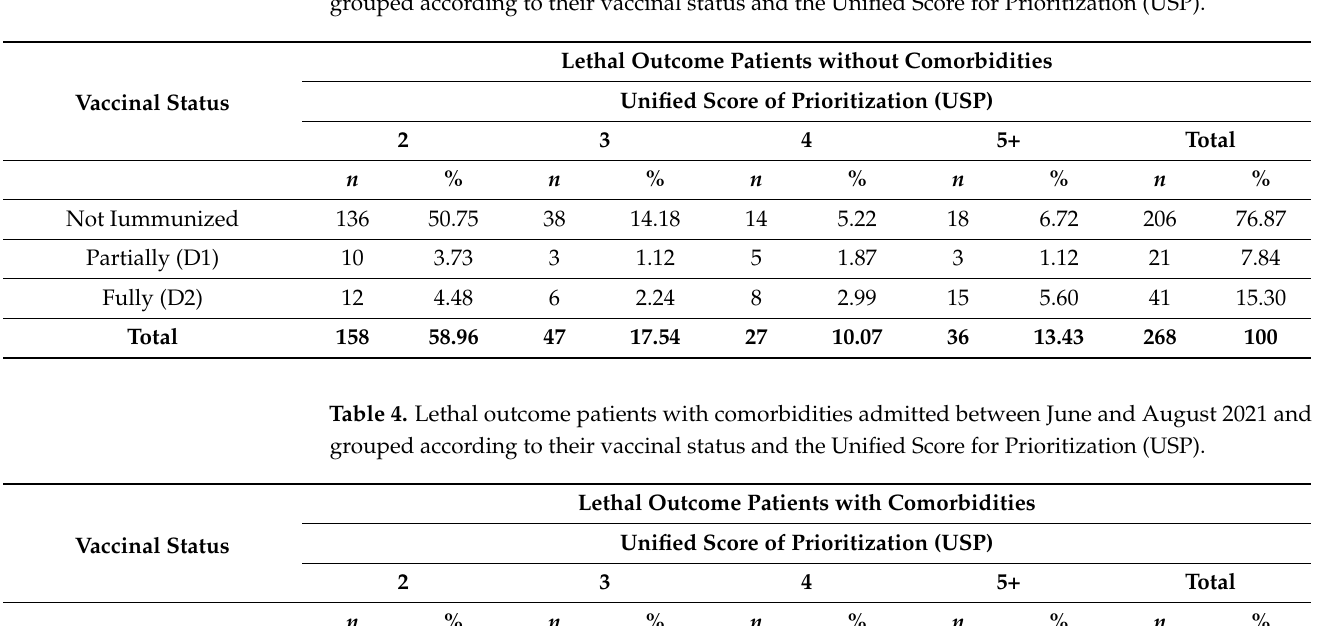
Table 3. Lethal outcome patients without comorbidities admitted between June and August 2021 and grouped according to their vaccinal status and the Unified Score for Prioritization (USP).